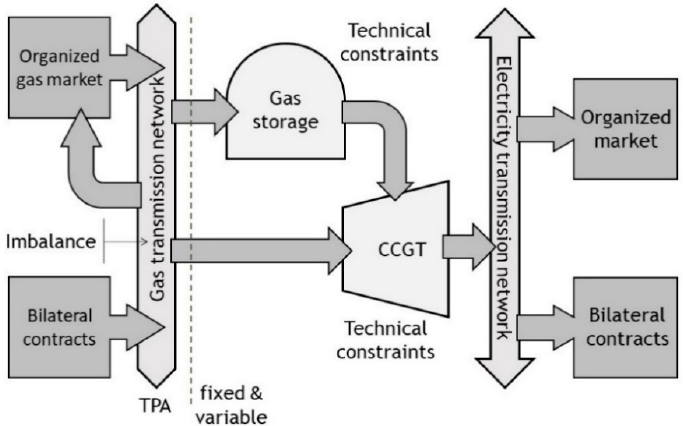
Figure 2. Decision-framework Figure 2. Decision ‐ framework structure. Figure 2. Decision ‐ framework structure.